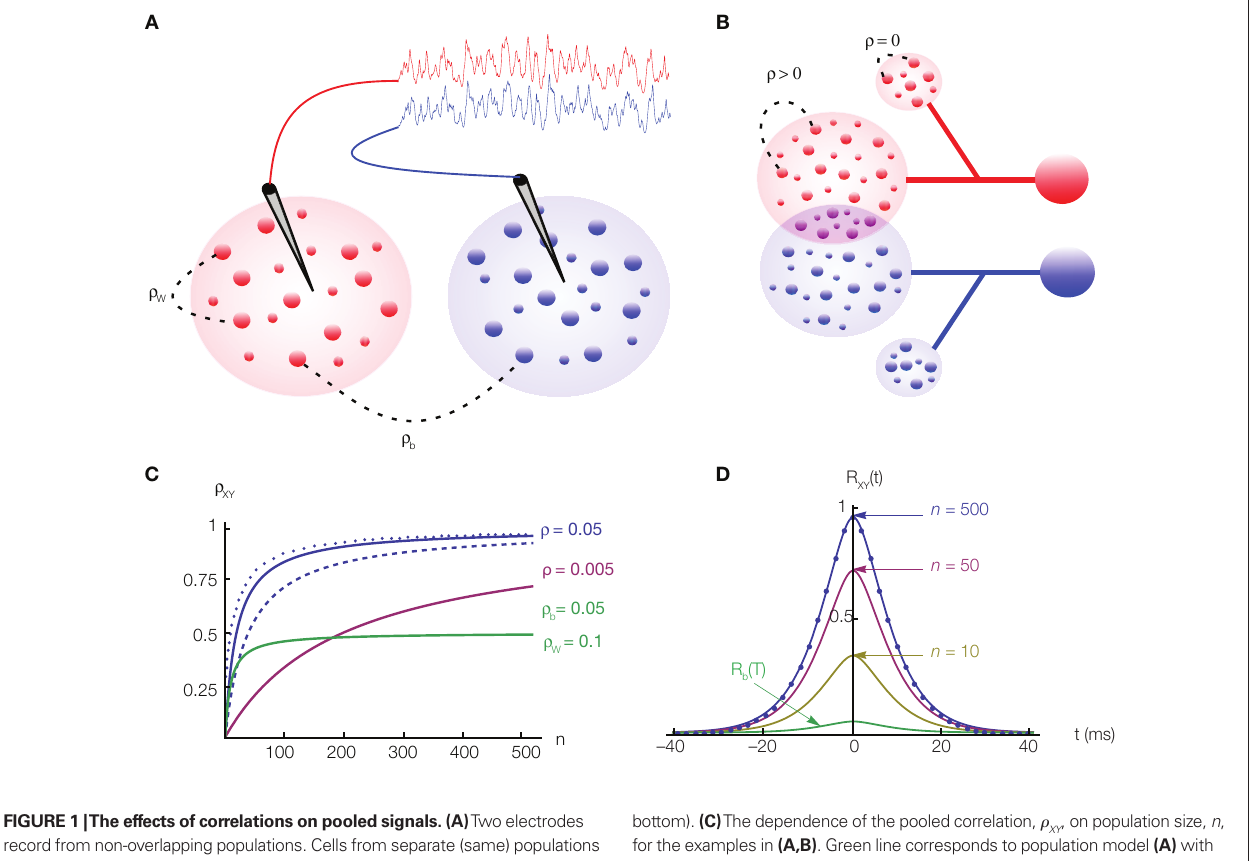
Figure 1 | The effects of correlations on pooled signals. (A) Two electrodes record from non-overlapping populations. Cells from separate (same) populations are correlated with coefficient r ( r ). The traces above the populations were b w obtained by convolving the pooled spike trains with an exponential kernel. Here r = r = 0.050 and n = 500. Although r is small, the traces are strongly b w b correlated. (B) Two cells receiving input from overlapping populations. Each of the two subpopulations on the left contain n cells. All pairs of cells within these subpopulations are correlated with coefficient r . The two cells on the right share np of their inputs from these subpopulations (purple intersection). Additionally, each cell receives nq uncorrelated inputs (smaller populations on top and